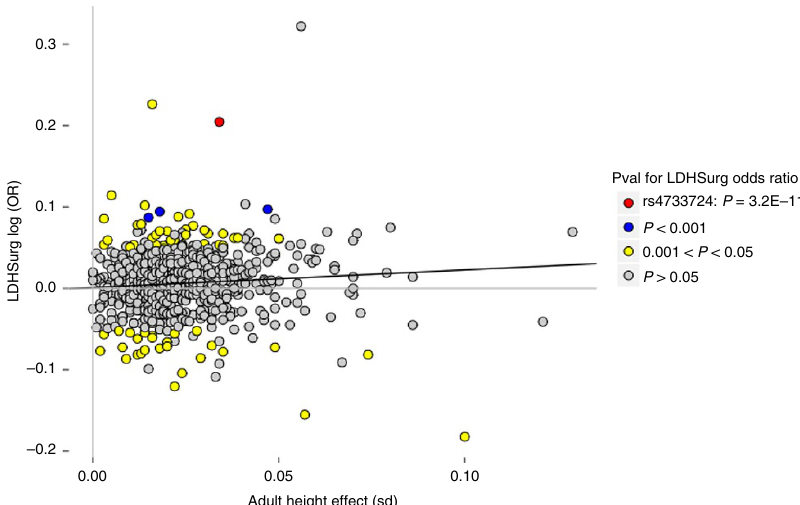
Figure 2 | Correlation of GIANT variants’ effect on height and risk of LDHsurg. Scatter plot showing how the 689 out of 697 adult height variants reported by GIANT 37 that we have LDHsurg association results for, affect adult height ( x axis) and LDHsurg ( y axis) in our data. The effect allele (minor or major) of each variant was concluded to be the one that has a positive effect on adult height in our data. The black solid line, y ¼ 0.0010 þ 0.22 x þ e, represents weighted linear regression, excluding rs4733724, with R 2 ¼ 0.0072 and P ¼ 0.026, using MAF(1-MAF) as weights. A t -test was used to calculate P